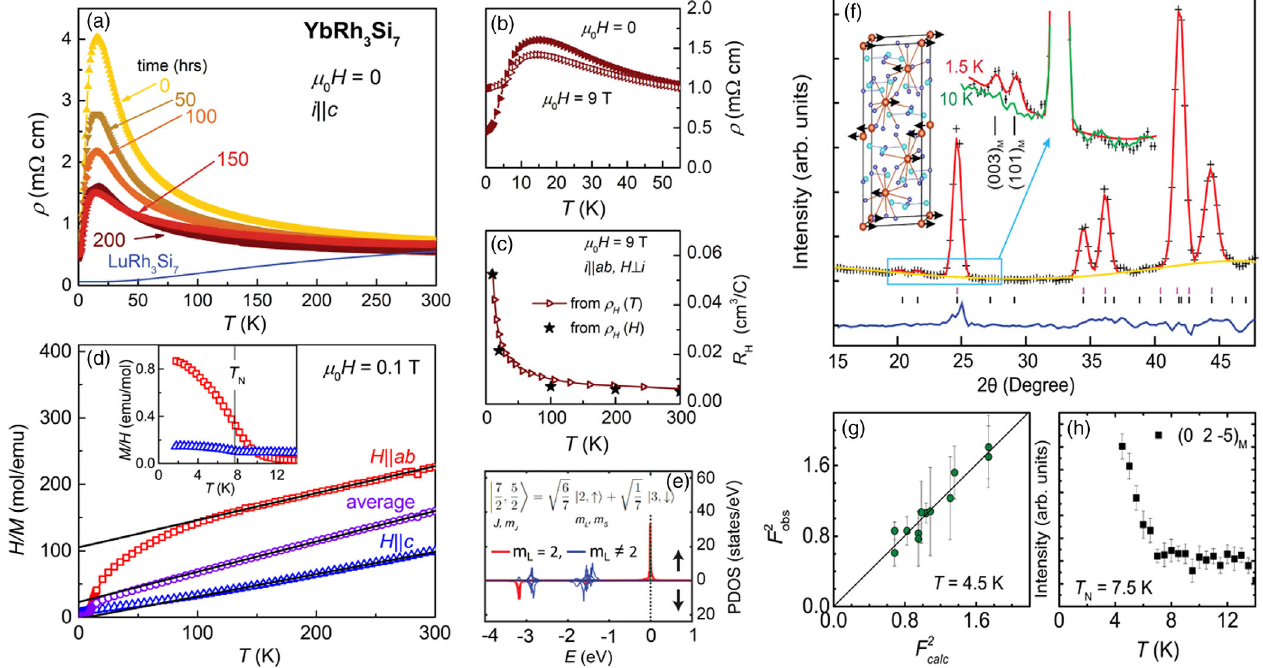
FIG. 1. (a) Zero-field temperature-dependent electrical resistivity ρ of YbRh 3 Si 7 at different annealing times. The solid line is the data for LuRh 3 Si 7 . (b) Low-temperature ρ at μ 0 H ¼ 0 and 9 T applied parallel to the c axis. (c) Hall coefficient R between 300 and 10 K. (d) Inverse magnetic susceptibility H=M vs T for YbRh 3 Si 7 with μ 0 H ¼ 0 . 1 T parallel to c (blue triangles) and ab (red squares) together with a polycrystalline average (purple circles) and Curie-Weiss fits (solid lines). Inset: Low-temperature magnetic susceptibility M=H . Note that 1 emu ¼ 1 G cm 3 ¼ 10 − 3 Am 2 . (e) DOS projected onto the orbital angular-momentum components of the Yb 3 þ ion. (f) Powder neutron diffraction patterns at 1.5 K (data, crosses; Bragg peak positions, short vertical lines; difference between data and refined pattern, indigo curve), with the AFM structure of the system with collinear moments parallel to the a axis (left inset) and an enhanced view of the (0 0 3) and (1 0 1) magnetic Bragg peaks at small angles (right inset). (g) Agreement of the single-crystal magnetic structure refinement at T ¼ 4 . 5 K. (h) Magnetic order parameter measured at the (0 2 – 5 Þ Error bars represent 1 standard